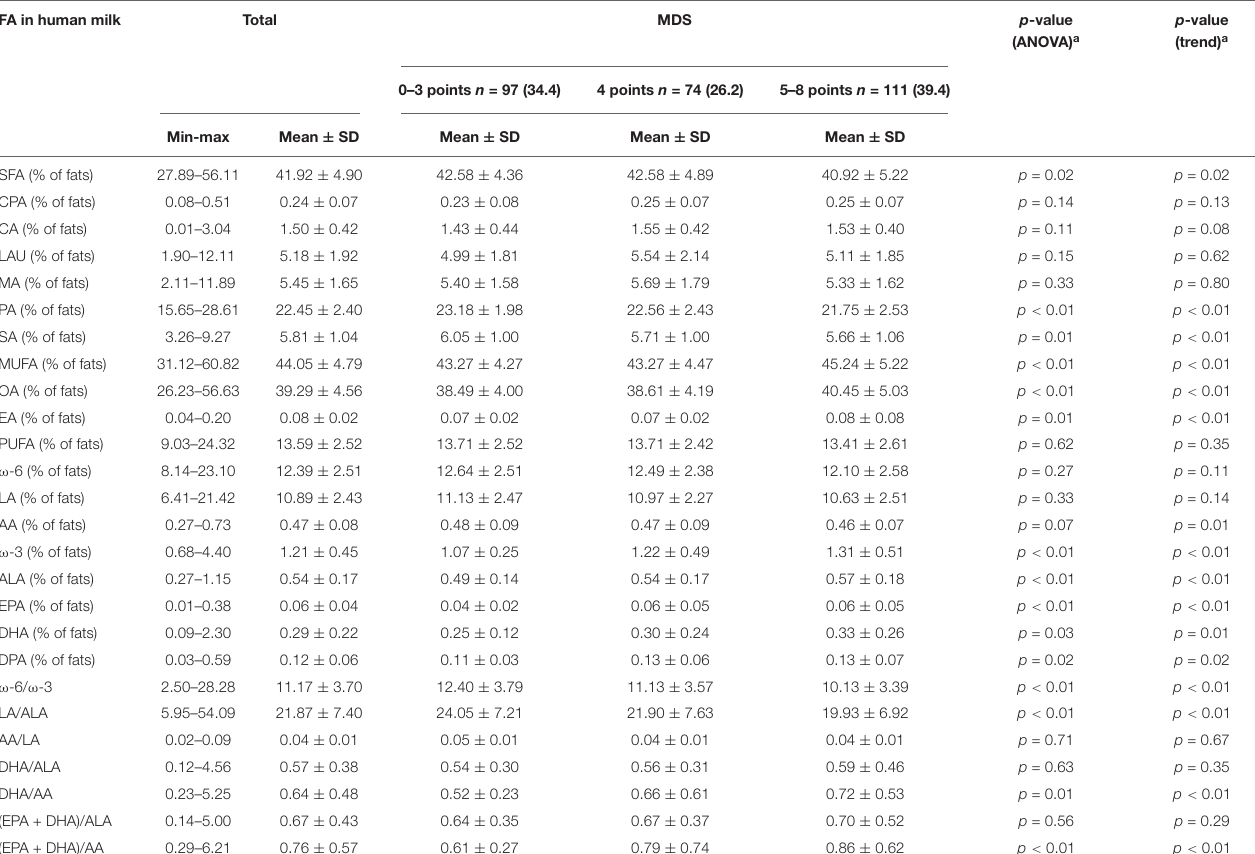
TABLE 3 | Mean and standard deviation contents of selected fatty acids (expressed as% of fats) in human milk according to the adherence of breastfeeding mothers to the Mediterranean Diet Score (expressed approximately in